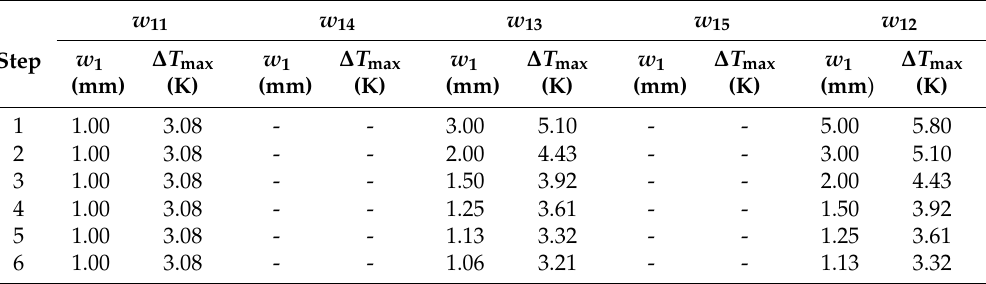
Table 9. The process of the optimization of w 1 ( w 2 = 20.0